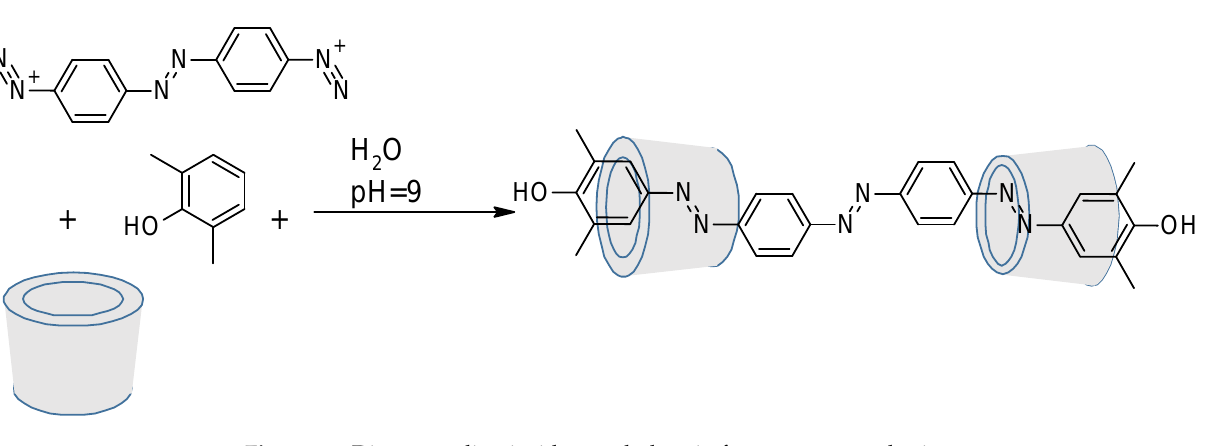
Figure 17. Excluding photochromic inhibitor. 4.2. Azo Functionalised Cyclodextrins Azo-modified cyclodextrins on their primary face have been investigated by two ap- proaches. The first one was a nucleophilic substitution with a mono-tosylated cyclodex- trin by a hydroxyazobenzene. The second one was done by click chemistry (Figure 18) [104].